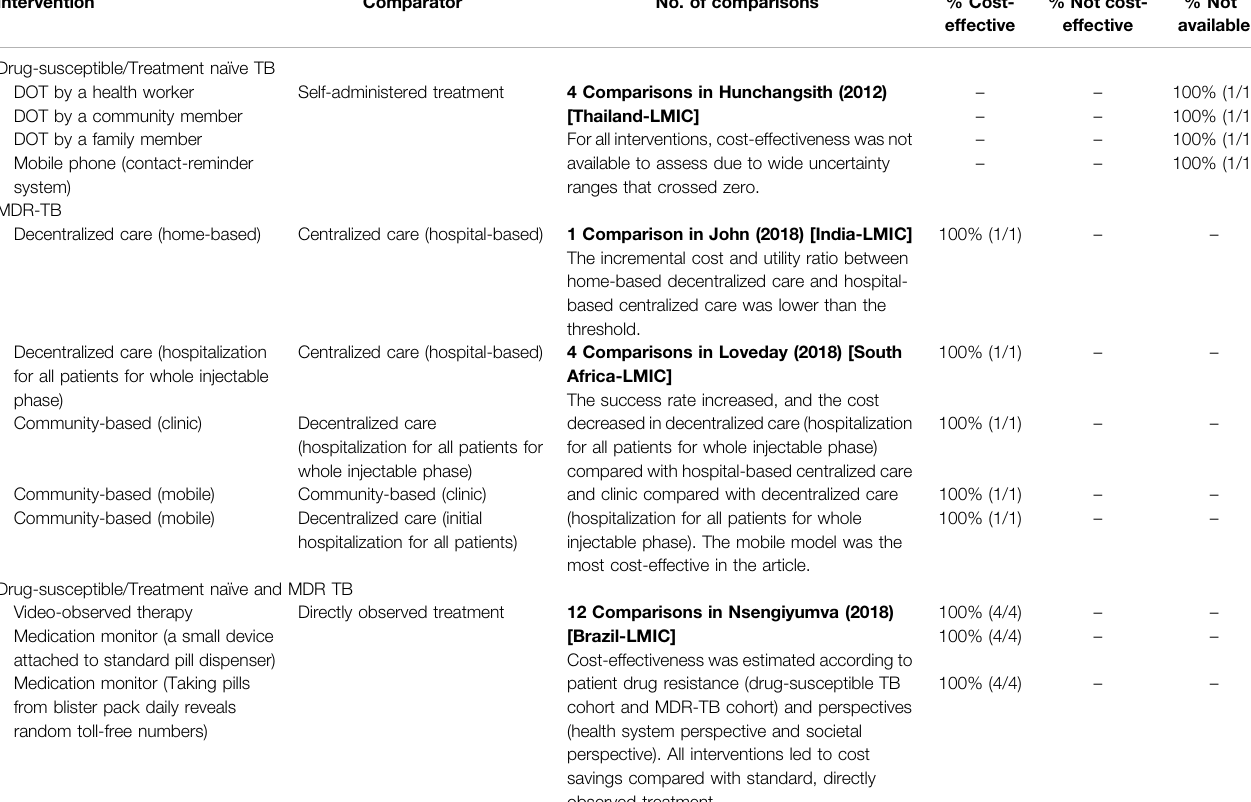
TABLE 4 | Cost-effectiveness of interventions in studies comparing types of care for active TB patients.